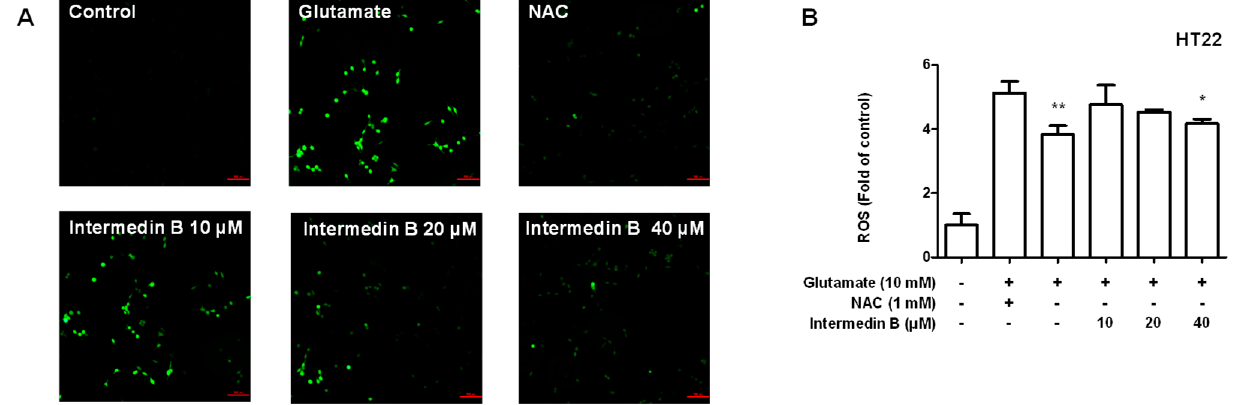
Figure 9. Effect of intermedin B ( 4 ) isolated from C. longa on inhibiting ROS production in glutamate- induced HT22 hippocampal cells. ( A ) HT22 hippocampal cells were pre-treated with intermedin B ( 4 ) for 3 h, followed by exposure to 10 mM glutamate for 8 h. The cells were then loaded with 10 µM 2 ′ -7 ′ dichloro fl uorescin diacetate (DCFH-DA) and measured using a fl uorescence microscope. ( B ) Fluorescence intensities were quanti fi ed using ImageJ software. The positive control group was treated with N-acetyl cysteine (Nac) 1 mM. Data are presented as the mean ± SD values of 3 inde- pendent experiments. * p < 0.05, and ** p < 0.01 compared with glutamate.